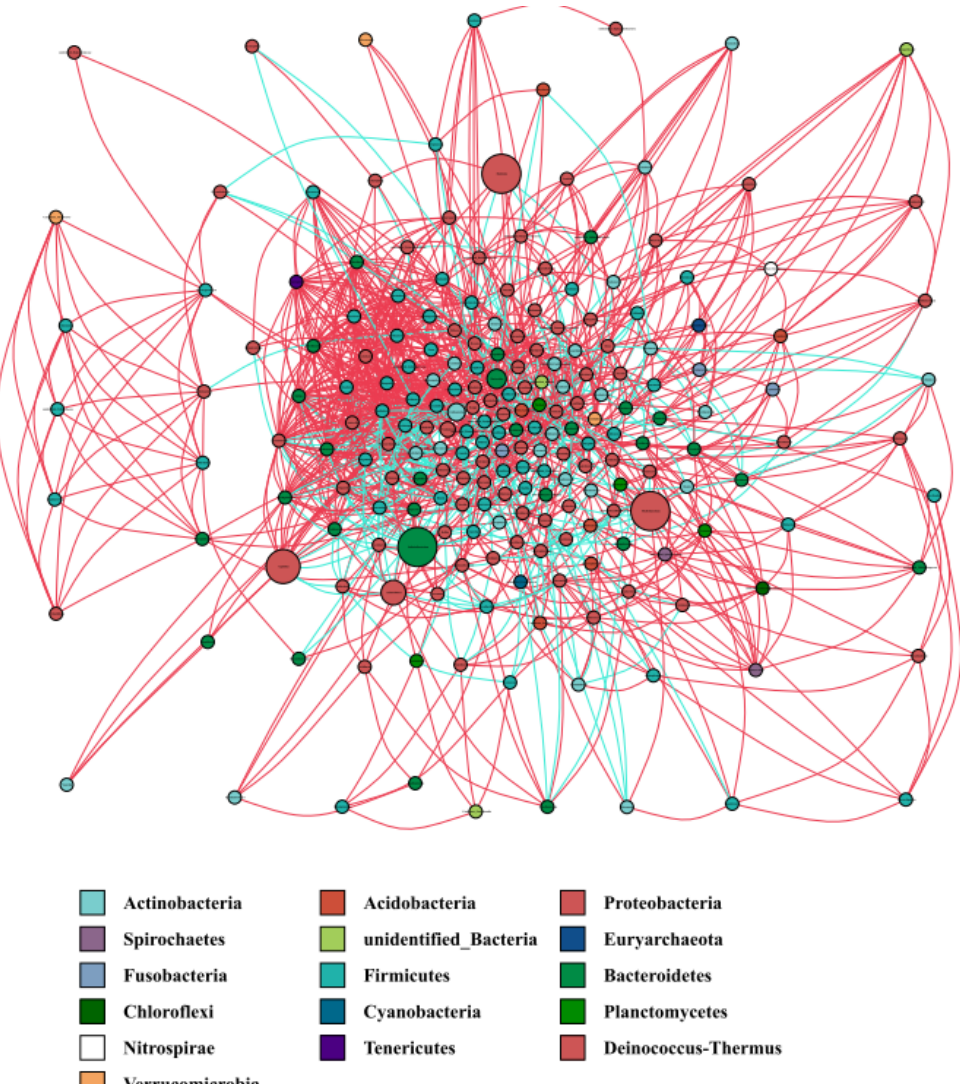
Figure 5. Co-occurrence network of water microbiota.